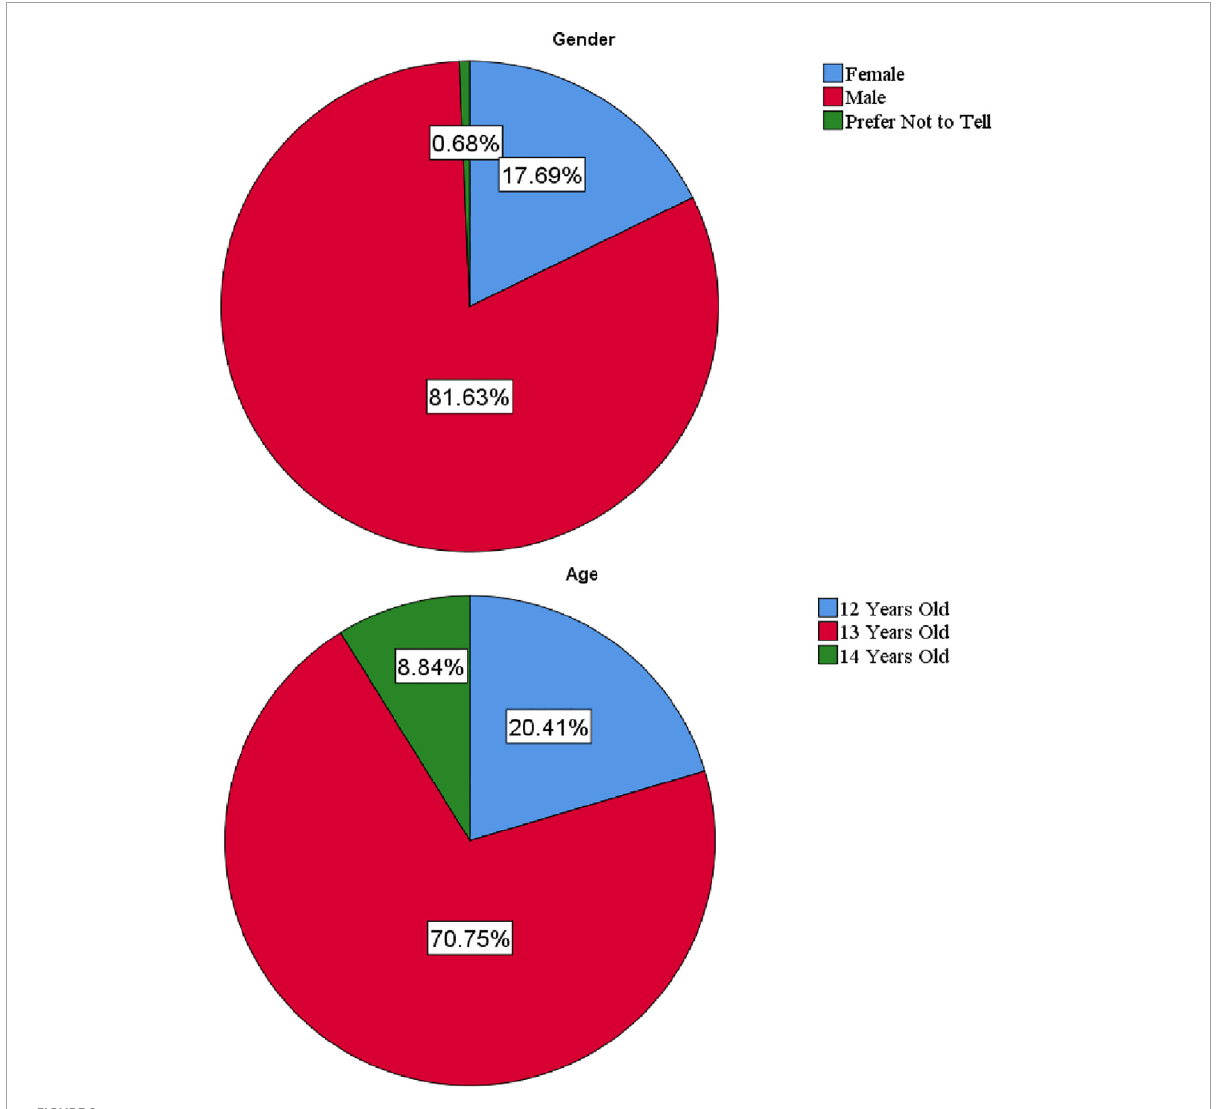
FIGURE2 Descriptive